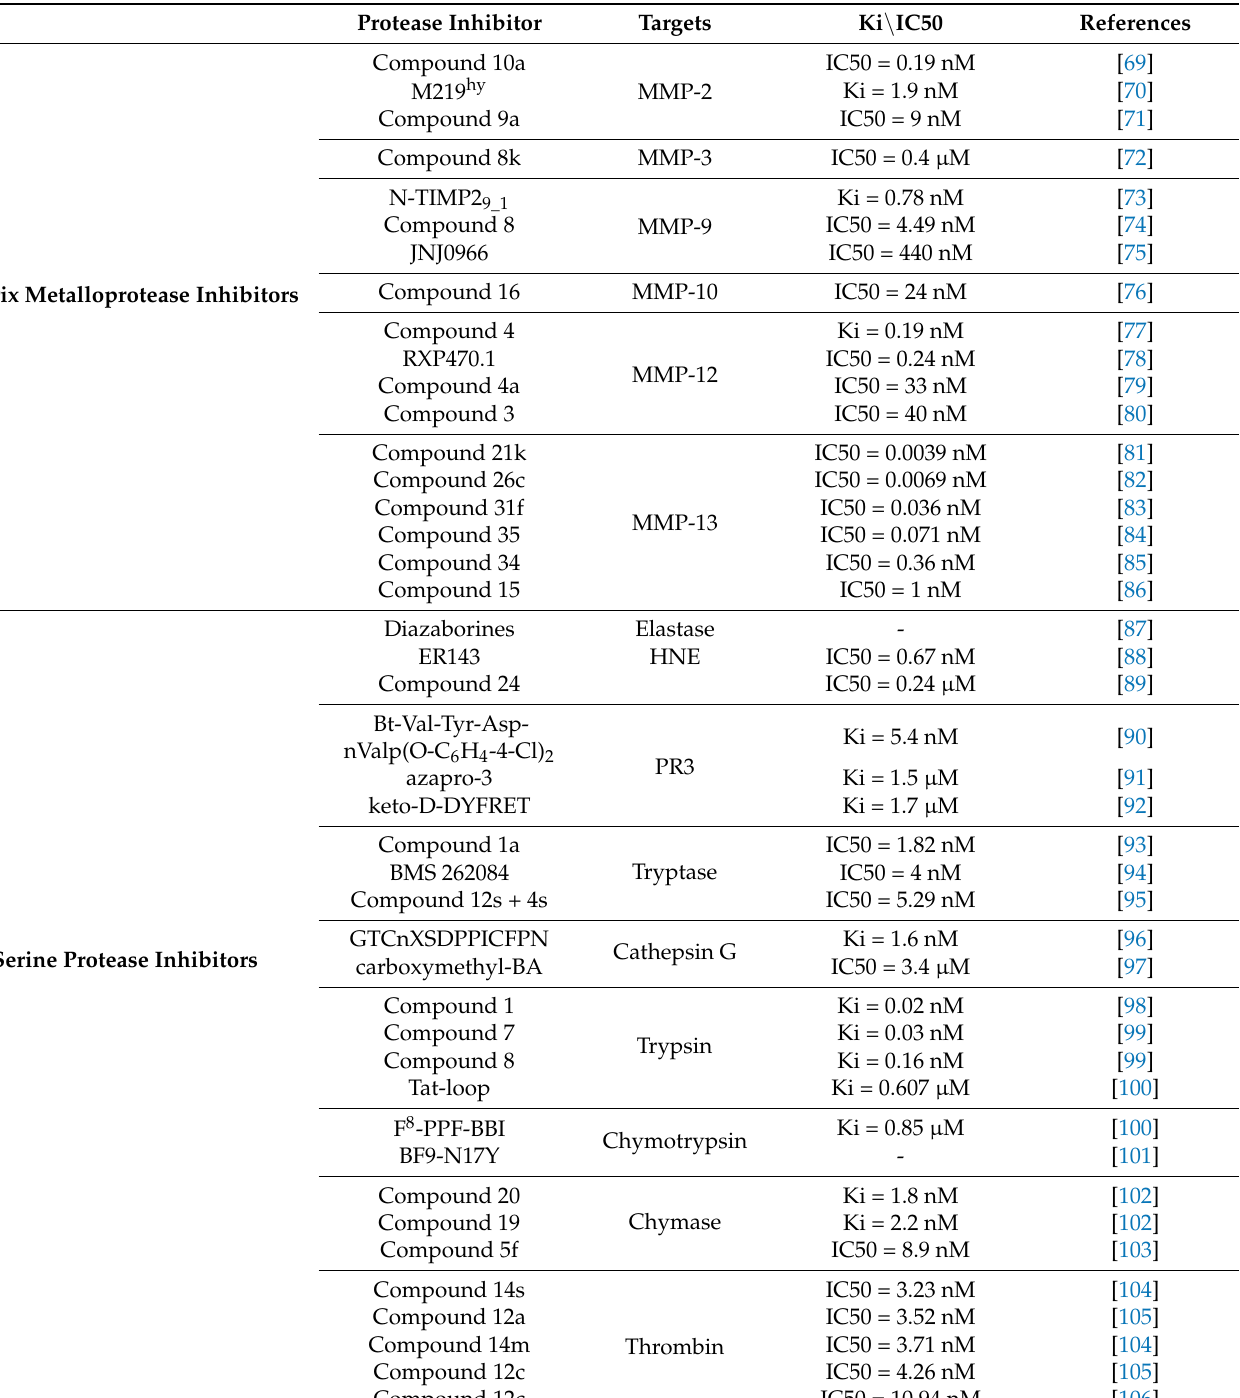
Table 1. Recent synthetic inhibitors of serine proteases and matrix metalloproteases (MMPs) developed as potential therapeutic